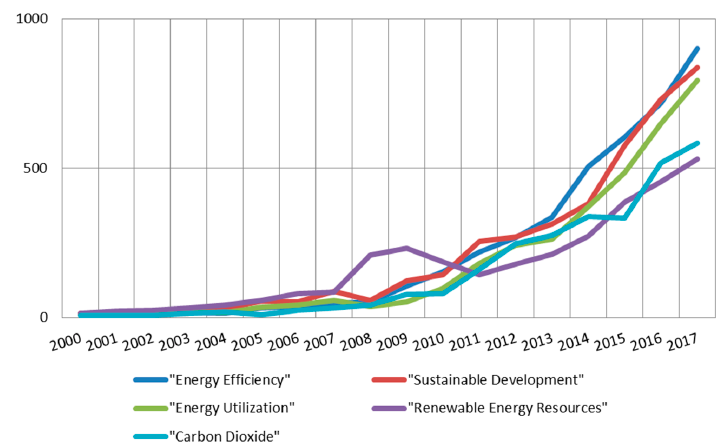
Figure 15. Trend of the five most used terms in the period 2000–2017.